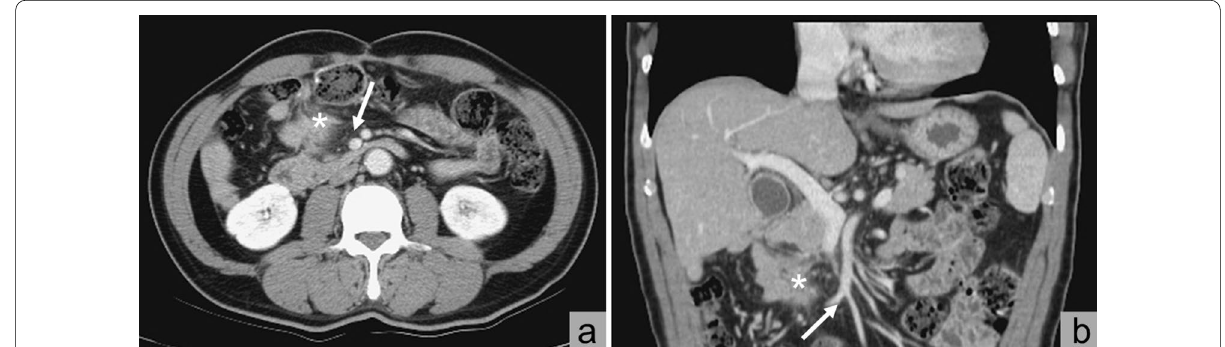
Fig. 1 Preoperative contrast‑enhanced CT study revealed a the relative position of the right mesenteric root (white arrow) and the lesion (white star sign) on axial view; and b the relative position of the right mesenteric root (white arrow) and the lesion (white star sign) on coronal view